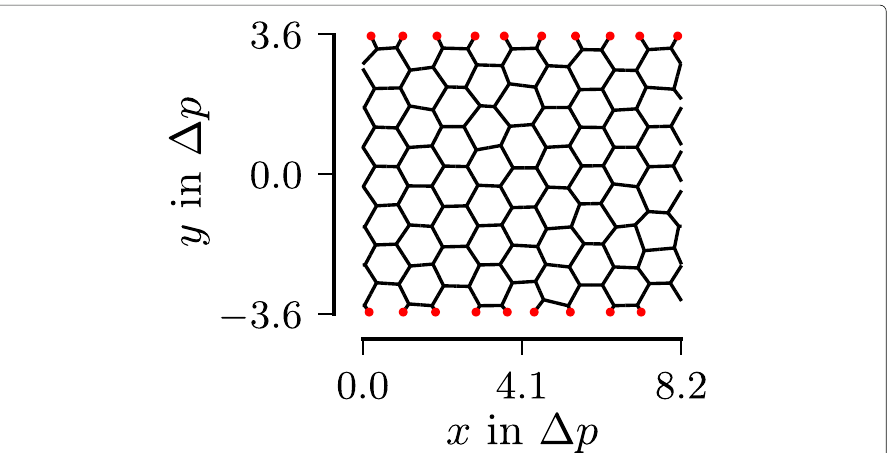
Fig. 1 Microstructure for small irregularity ( β = 0.05), system height H = 7 (cid:2) p ; boundary conditions are applied at the surface nodes marked in red while the left and right boundaries are free; note that a small shift of the structure to the left would open the cells at the left boundary and considerably reduce the stiffness of the structure under the imposed